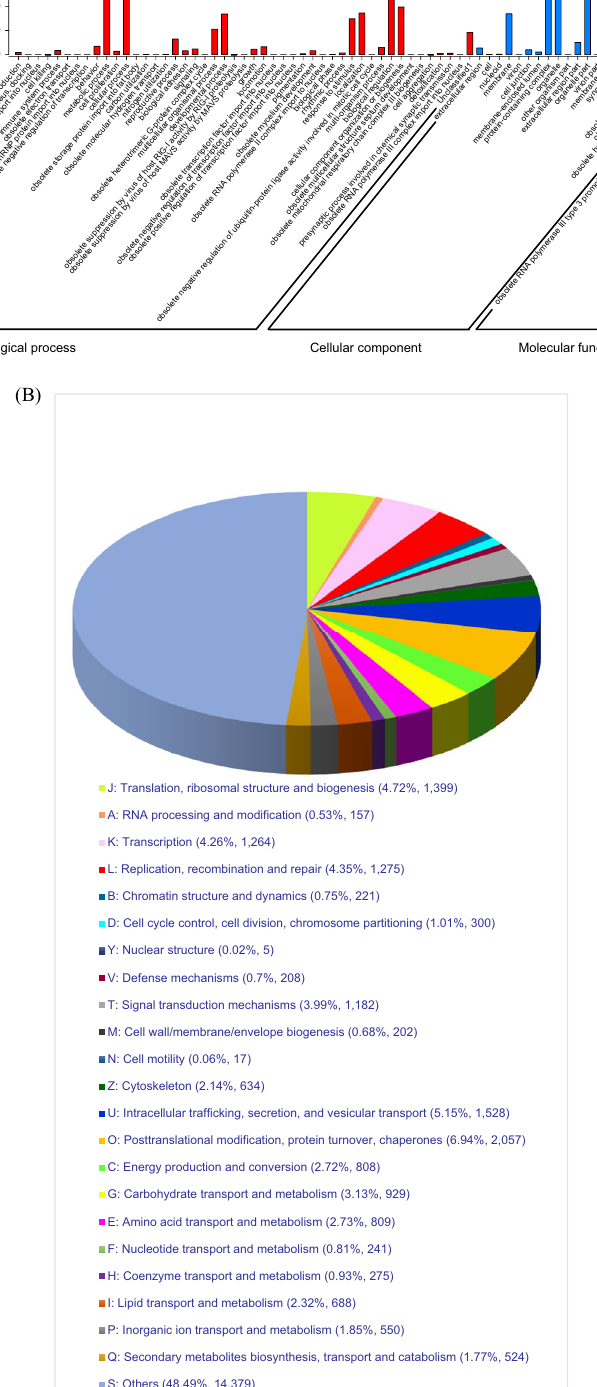
Figure 2. Annotations of the annotated unigenes. ( A ) The Gene Ontology (GO) classification of all annotated unigenes. 22,091 unigenes were assigned to three main GO categories of ‘Biological process with 46 functional subcategories’, ‘Cellular component with 21 functional subcategories’, and ‘Molecular function with 19 functional subcategories. The Y axis shows the number of genes in each category. Some unigenes were not classified and were shown as ‘Unclassified’ in each category. ( B ) The annotated unigenes are mapped to the annotation of the corresponding orthologous groups in the EggNOG (Evolutionary genealogy of genes)